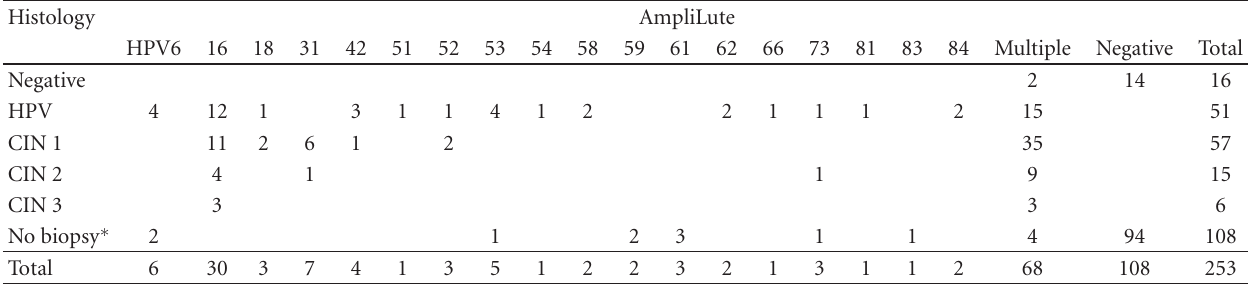
Table 7: Distribution of HPV types (in single infections) detected by AmpliLute method against Histological Diagnosis.